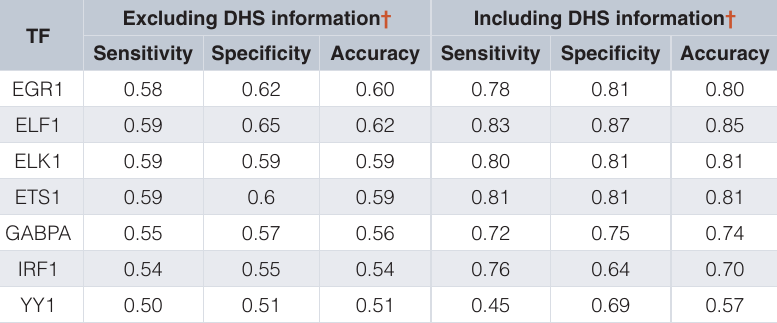
Table 2. The Decision Tree classifier performance for predicting TF targets using the CRISPR-generated knockdown data.